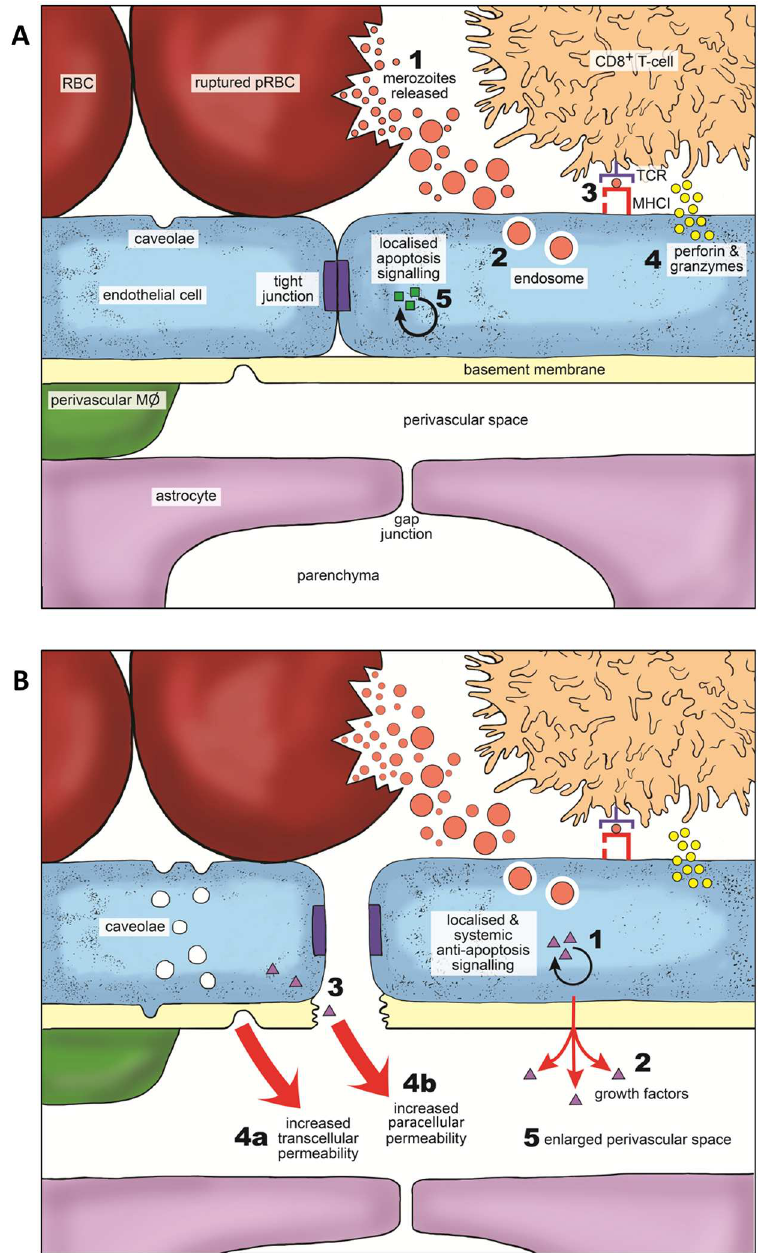
Fig 12. Model for ECM-associated vascularleakage. (A) 1) Arrested Schizont ruptures in the cerebral capillaryreleasingmerozoites. 2) pRBC-dependent alterationsin cerebralcapillaryblood flow facilitate EC phagocytosis of merozoites and digestive vacuoles. 3) ECs cross-present parasite antigenon MHC class I moleculesto CD8 + T-cells. 4) CD8 + T-cells degranulate and release cytotoxic perforin and granzyme molecules). 5) The cytolytic moleculesinduceapoptosissignallingwithin the target EC. (B) 1) Target EC inducesanti-apoptosis signallingpathways to counteract cytolysis via 2) the secretionof growth factors. Growth factors act in an autocrinefashionon the target EC and 3) paracrinefashionon neighbouring ECs. This results in: 4a) the upregulation of caveolaewithin affected ECs; and 4b) alterations to intercellularEC tight junctions.5) The enhancedpermeability of the cerebrovasculature leads to enlargement of the perivascular spaces and formation of oedematous parenchymal tissue, which precipitatefatal increasesin